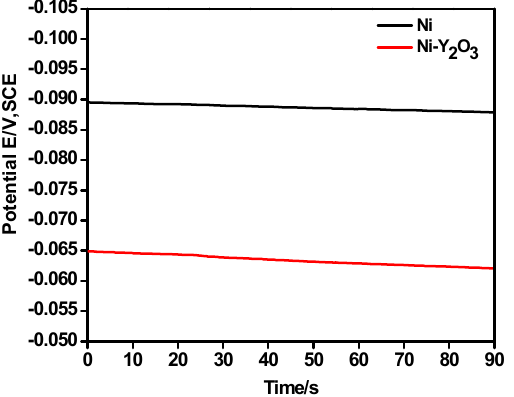
Figure 3. Open circuit potential (OPC) plots of nickel and composite deposits measured from sulfamate solutions.